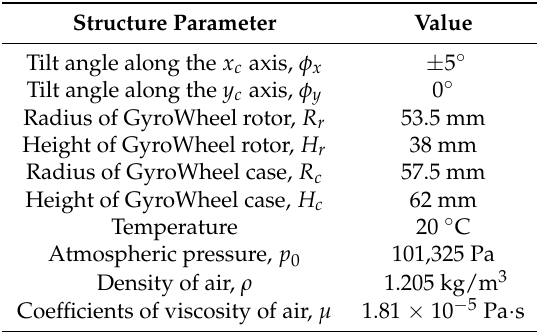
Figure 5. Schematic of the tetrahedral mesh with a number of 1987570. ( a ) Body mesh around the GyroWheel system; ( b ) Surface mesh of the GyroWheel rotor. Table 2. The simulation parameters.